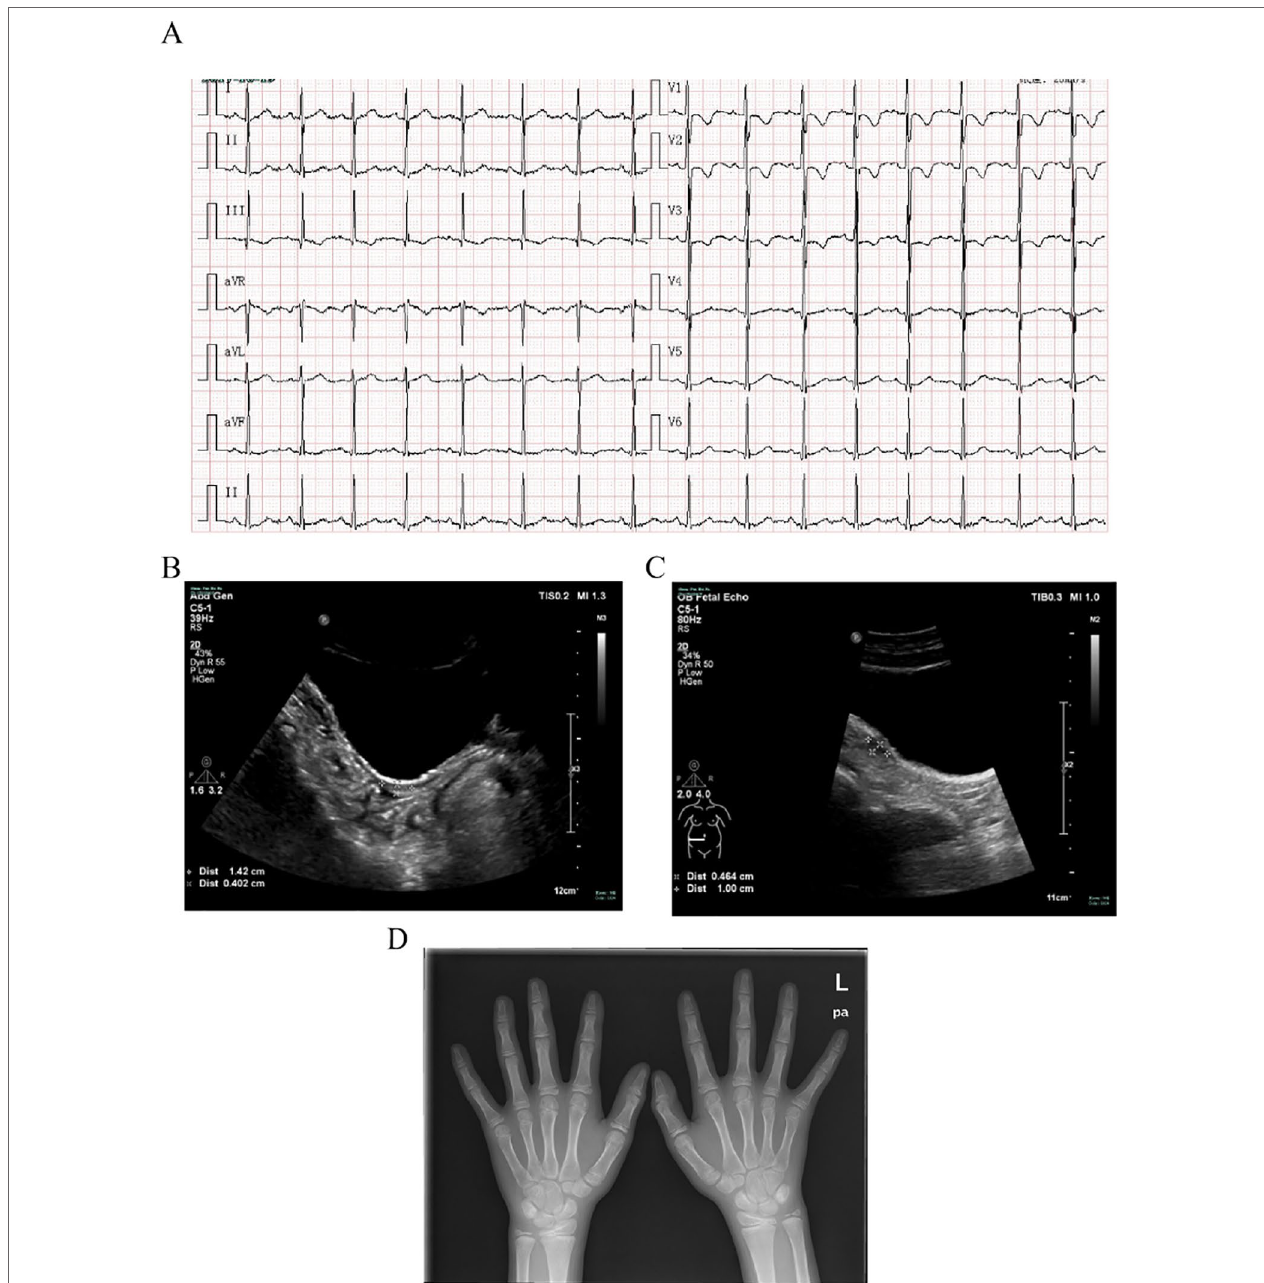
FigURe 1 | Clinical evaluations. (A) Electrocardiogram revealing signs of hypokalemia with sinus tachycardia and ST-T changes. (B) Pelvic ultrasound showing that the size of the uterus is about 1.4 cm × 0.4 cm × 0.7 cm. (C) Pelvic ultrasound also showing that the size of the suspected right ovary is about 1.0 cm × 0.5 cm × 0.5 cm but the left ovary is undetectable. (D) X-ray imaging of the phalanx, carpal, and radioulnar bones. Greulich-and-Pyle methods are used to evaluate bone age.